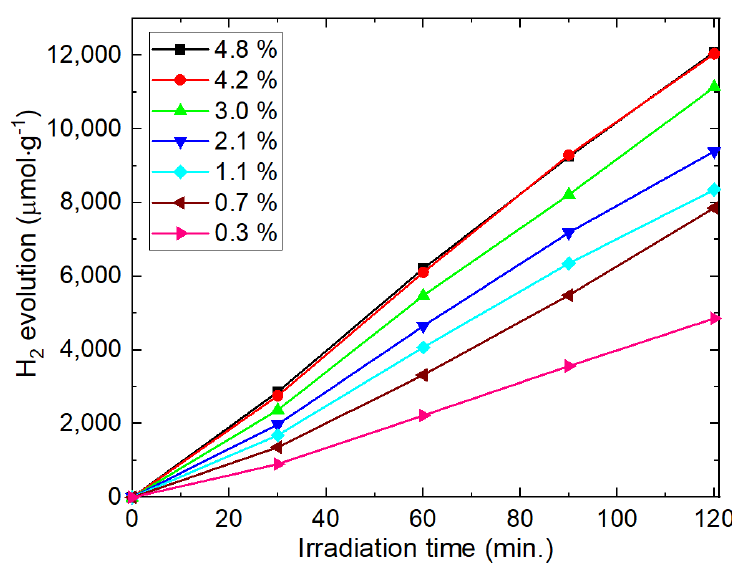
Figure 7. Dependence of H 2 evolution on the content of Pt cocatalyst with CdS nanocomposite.